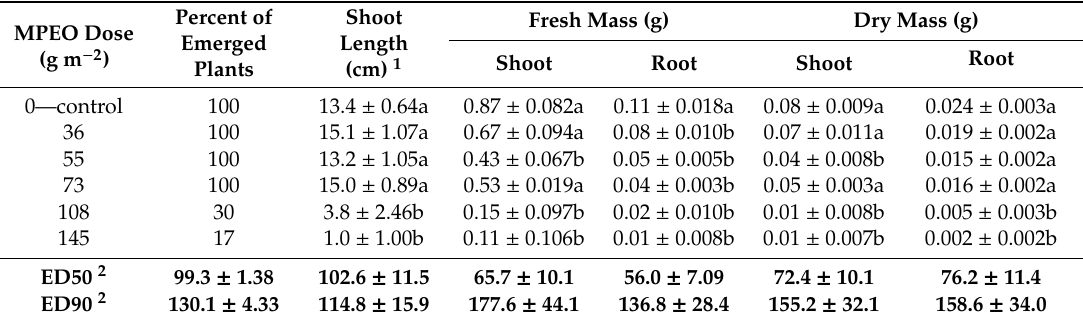
Table 3. Length of white mustard cv. ‘Zlata’ shoots and roots and their biomass at the growth stage of two pairs of true leaves (BBCH 14) after 8 weeks of growth in a silty clay loam soil substrate amended with di ff erent doses of microencapsulated peppermint essential oil (MPEO with 9.6% (v / w) of peppermint EO content).